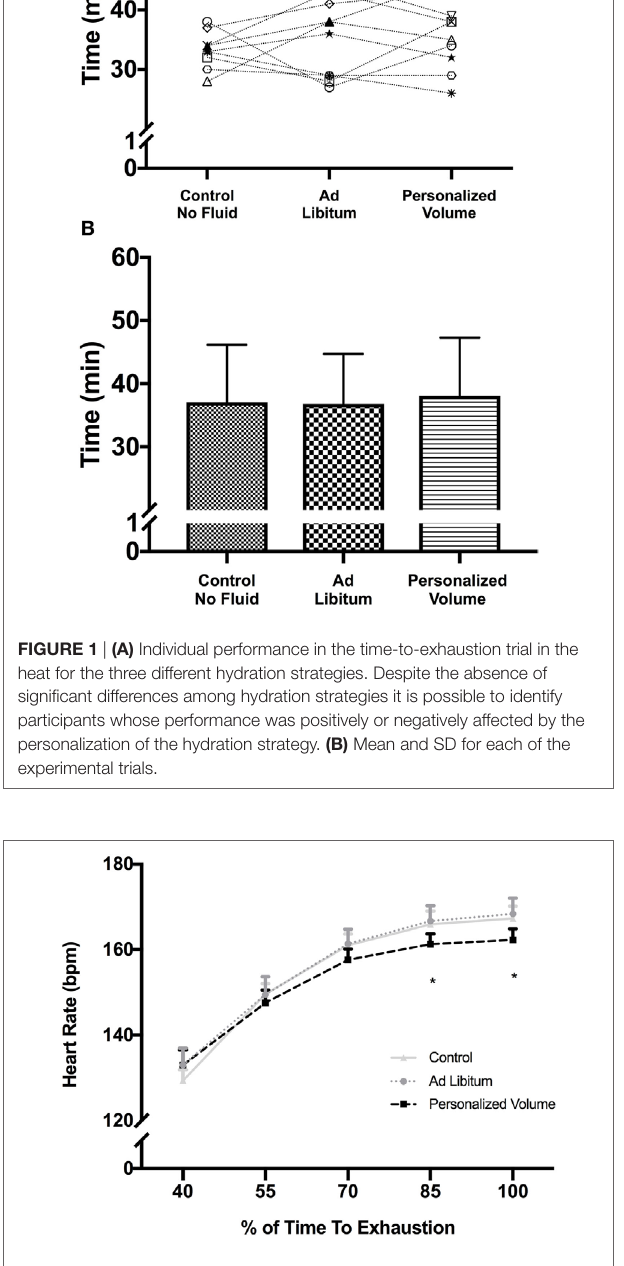
FigUre 2 | Heart rate response during exercise in the heat for each of the experimental trials. * p < 0.05 in comparison with control and Ad Libitum trials.